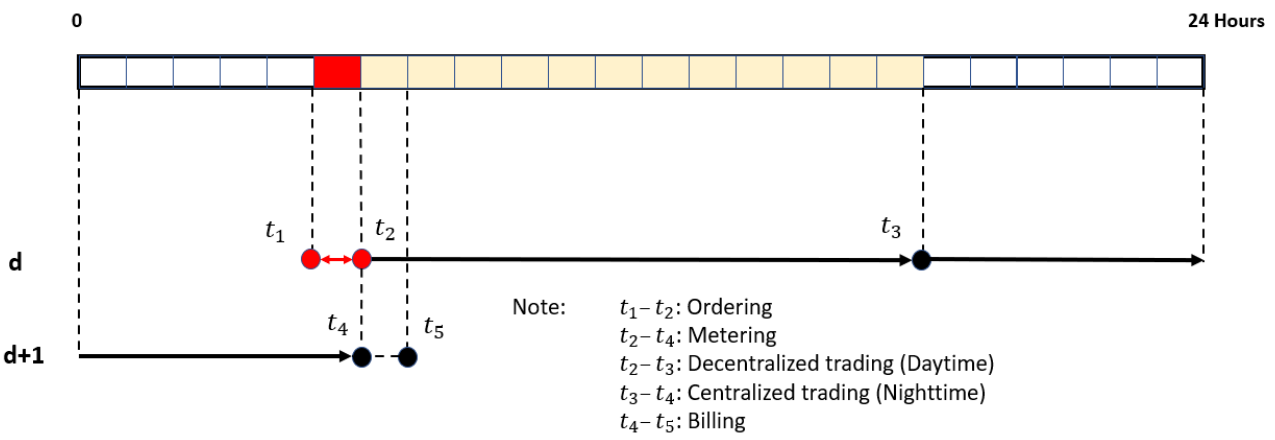
Figure 1. Process scheduling.